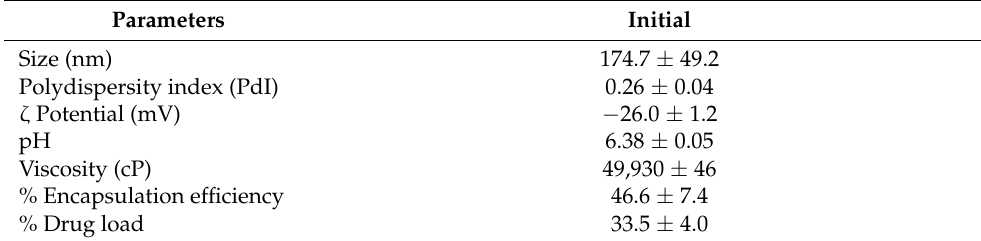
Table 3. Physicochemical properties of formulated LNF.